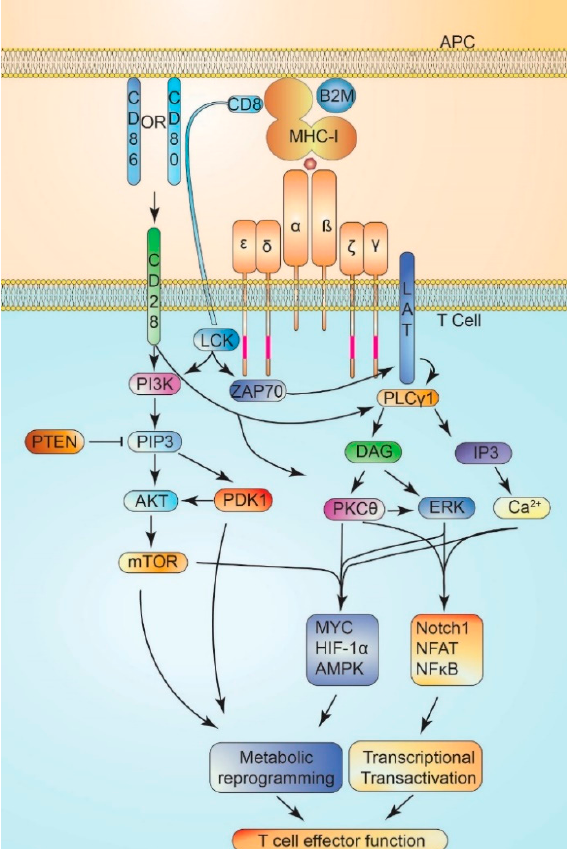
Figure 1. T cell activation and metabolic reprogramming. T cell receptor (TCR) activation occurs following engagement of the α ß dimer with peptides presented by MHC-I (or MHC-II)(major